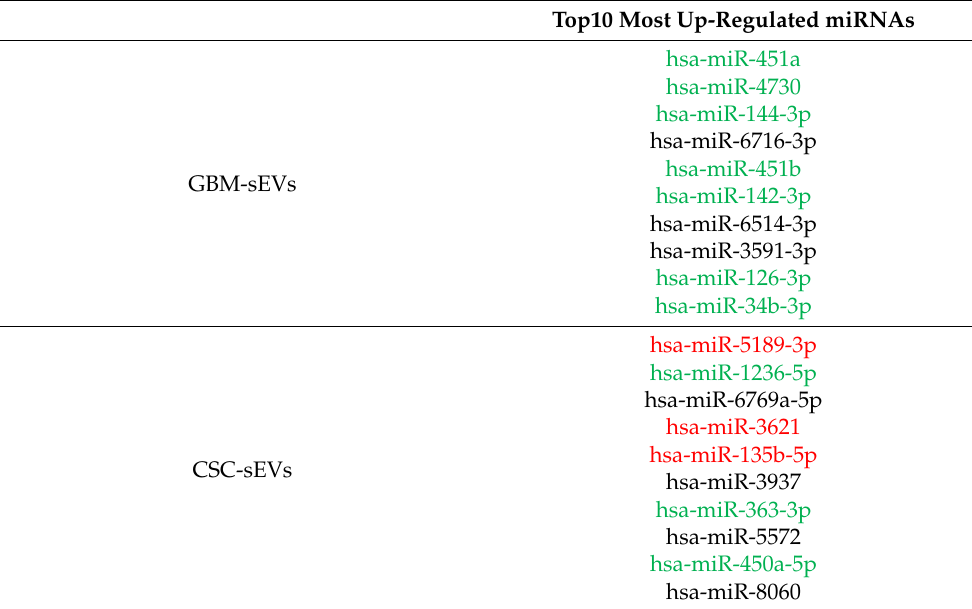
Table 1. Top 10 most up-regulated (top10) miRNAs in GBM-sEVs as compared to CSC-sEVs (upper) and top 10 miRNAs in CSC-sEVs as compared to GBM-sEVs (lower). Top10 Most Up-Regulated miRNAs hsa-miR-451a hsa-miR-4730 GBM-sEVs